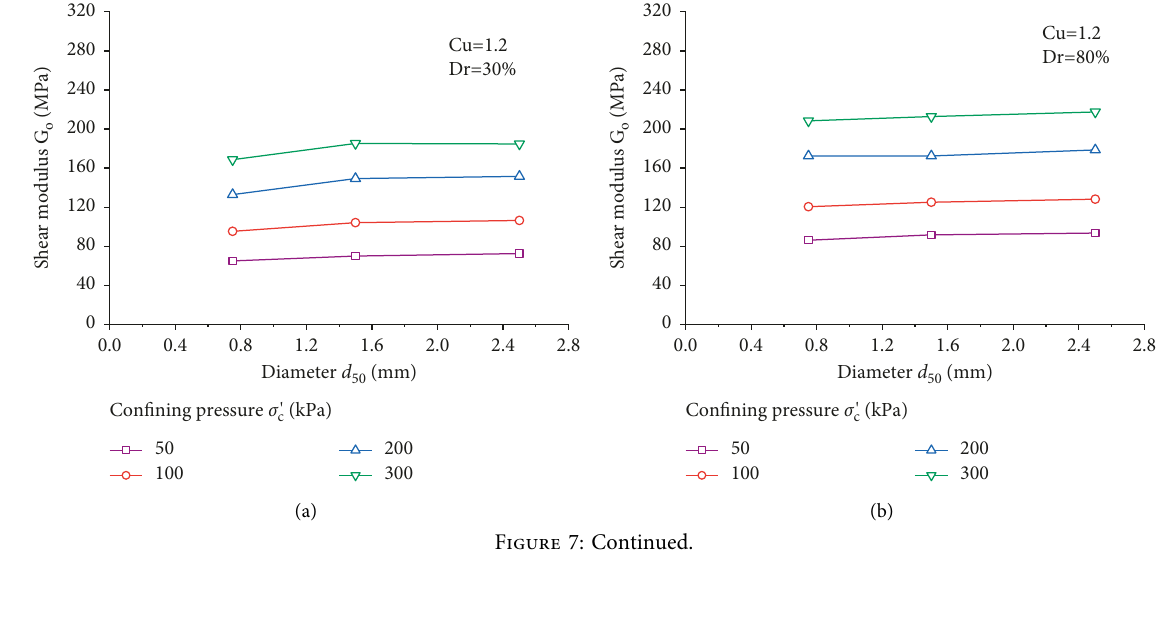
Figure 6: Maximum shear modulus G (b) d 50 �